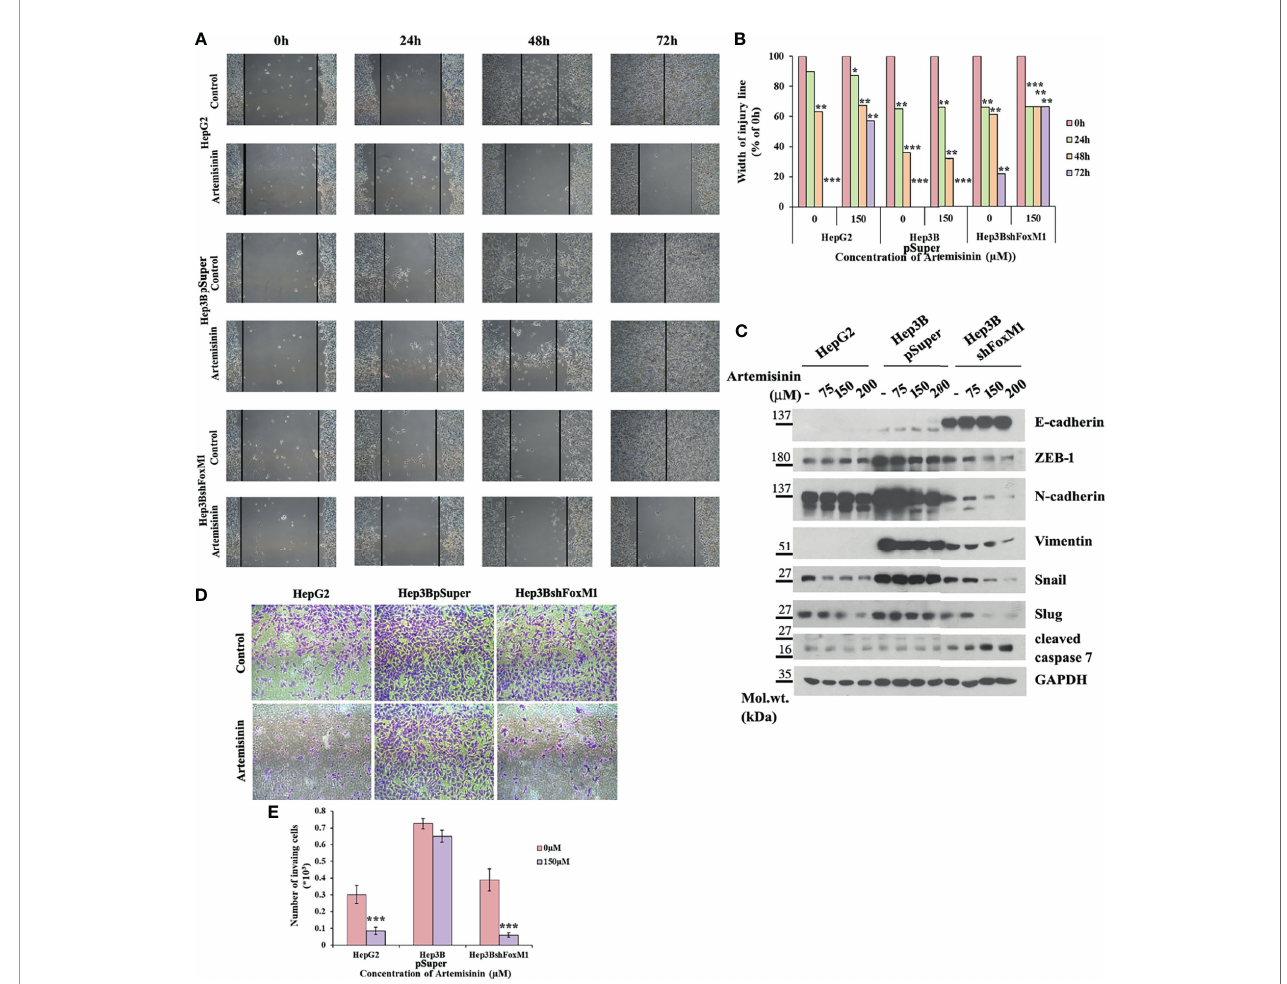
FIGURE 4 | Artemisinin attenuates the transformative capacity of resistant HCC cells following FoxM1 silencing. (A) HepG2, Hep3BpSuper and Hep3BshFoxM1 cells were subjected to scratch assay. Representative images of gap closure are shown. (B) The width of the wound remaining was measured and graphically depicted. (C) Equal amounts of cell lysates following Artemisinin treatment for 48 h were subjected to SDS-PAGE and immunoblotted with antibodies speci fi c for E- cadherin, ZEB-1, N-cadherin, Vimentin, Snail, Slug and cleaved caspase 7. GAPDH served as a loading control. (D) Matrigel invasion assay was executed for cells following 48 h exposure to Artemisinin. Representative images are provided. (E) Bar graph depicting the number of invading cells. * p < 0.05, ** p < 0.01, and *** p < 0.001. All data are expressed as the means ± standard deviations from triplicate experiments. The two-tailed Student ’ s t -test was used to determine whether the differences between vehicle-treated set and Artemisinin-treated set were signi fi